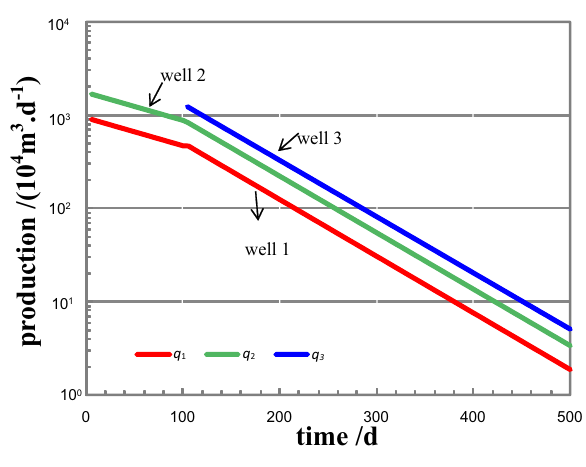
Fig. 3 The curves of flow rate versus time